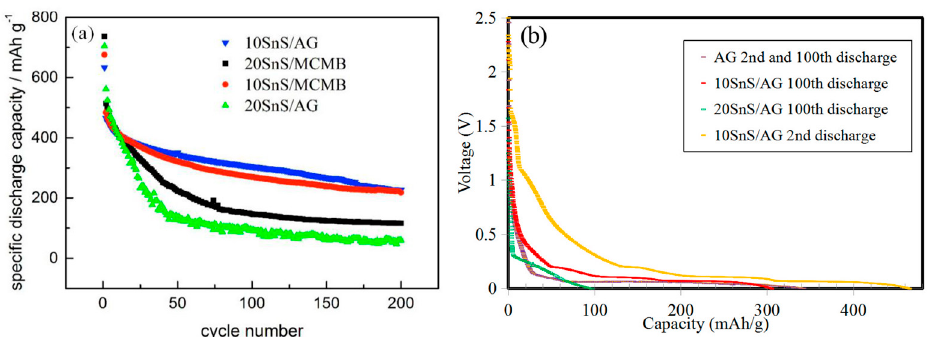
Figure 4. ( a ) Cycling performance of the different SnS/C samples; ( b ) discharge voltage capacity profiles for the 100th discharge of the 10SnS/AG, 20SnS/AG, and AG, and for the 2nd discharge of the 10SnS/AG.